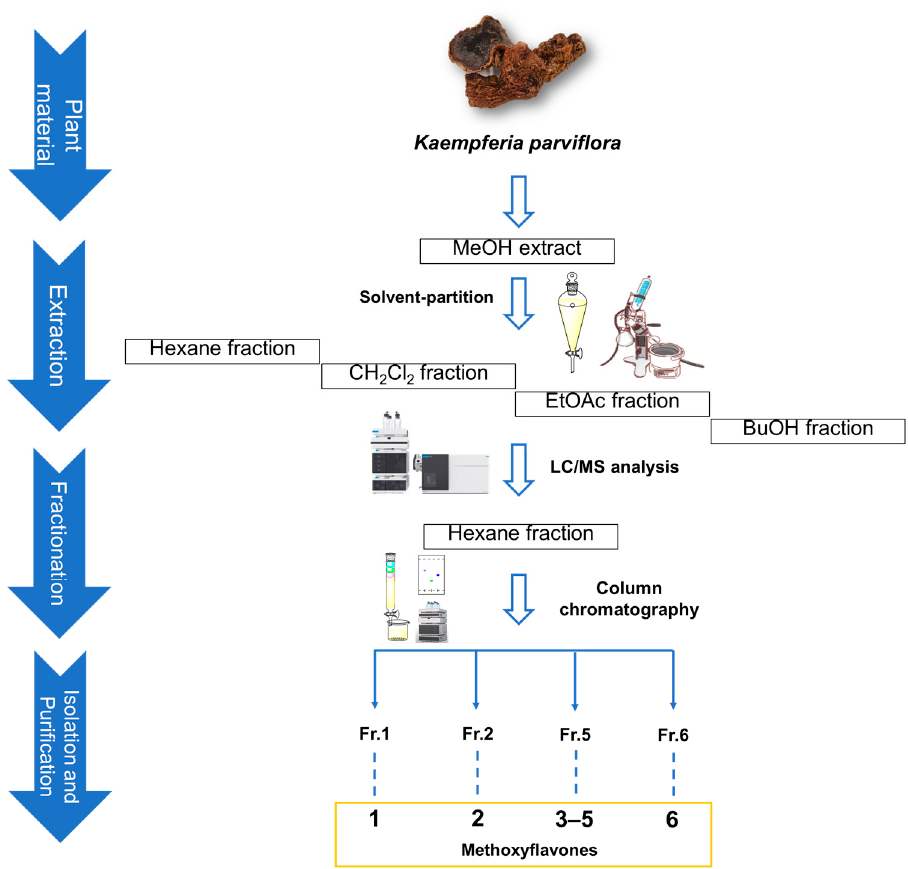
Figure 1. Separation scheme of Compounds 1 – 6.